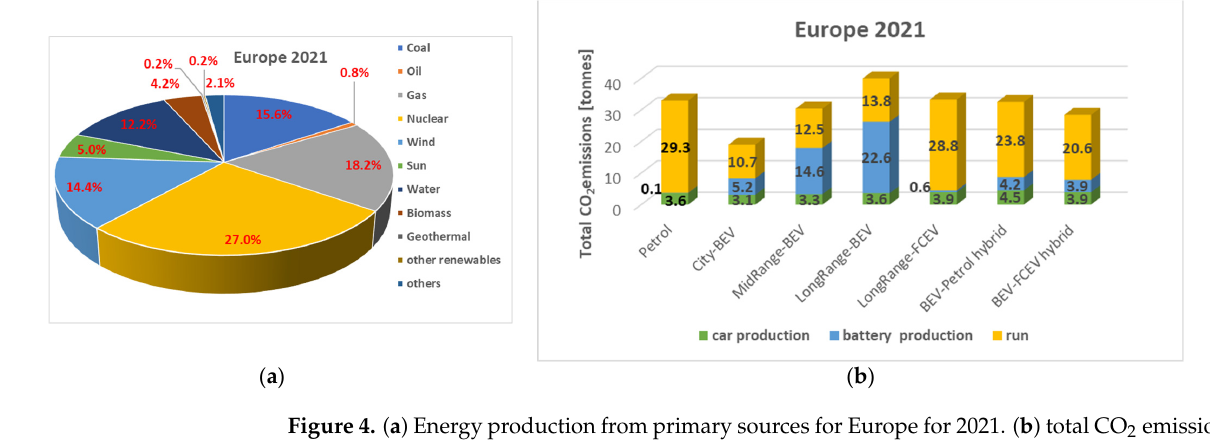
Figure 3. ( a ) Energy production from primary sources for Romania for 2021 ( b ) total CO 2 emissions for 2021 for Romania for different types of cars, including car and battery production, as well as running of the vehicle considering different sources for energy production.